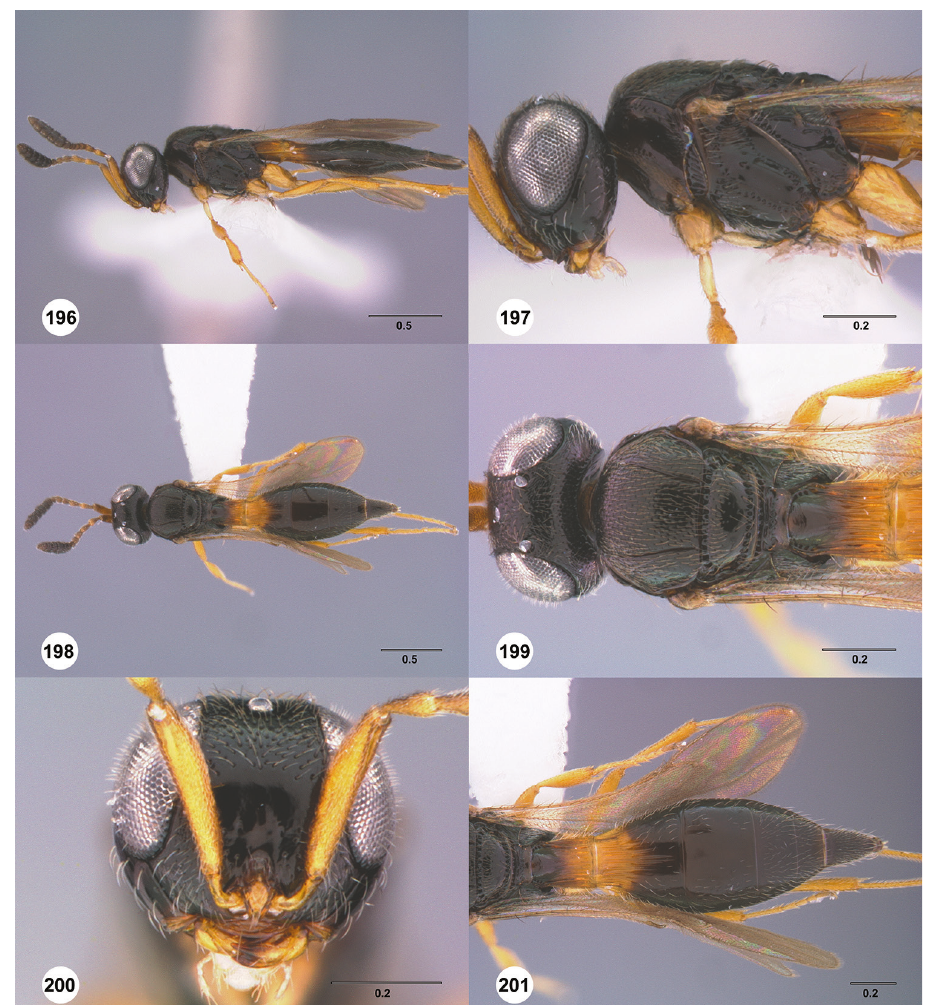
Figures 196–201. Calliscelio punctatifrons sp. n., female, holotype (OSUC 191124). 196 Lateral ha- bitus 197 Head and mesosoma, lateral view 198 Dorsal habitus 199 Head and mesosoma, dorsal view 200 Head, anterior view 201 Metasoma, dorsal view. Scale bars in millimeters. sparse punctures. Ocular setae: dense, long. A4 in female: distinctly shorter than A3. A5 in female: shorter than A3, as long as wide. Shape of female A6: distinctly wide than long. Form of male antennal flagellomeres: filiform, A11 approximately 2.5× longer than wide. Length of A5 tyloid in male: greater than 0.5× length of A5. Color of mesosoma in female: black throughout. Color of mesosoma in male: black throughout. Sculpture of dorsal pronotal area: areolate. Sculpture of lateral pronotal area: smooth throughout. Sculpture of netrion: striate. Notaulus: percurrent or nearly so. Sculpture of mesoscutum: smooth with sparse punctures; coriaceous